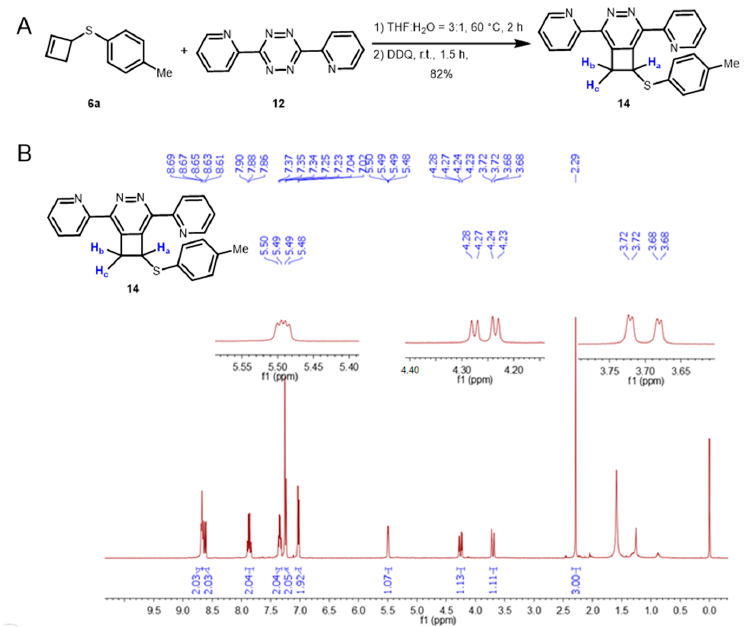
Figure 2. ( A ) IEDDA-oxidation cascade reaction of cyclobutene 6a with dipyridinetetrazine 12 . ( B ) The 1 H–NMR spectrum of compound 14 .